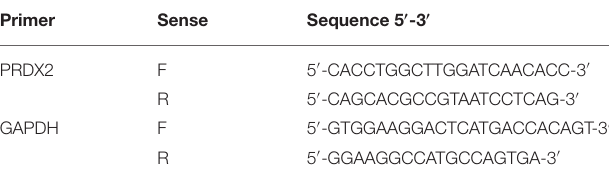
TABLE 2 | Primer sequences used in the